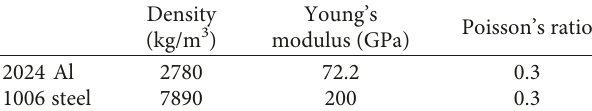
Table 1: Mechanical parameters for the airplane.